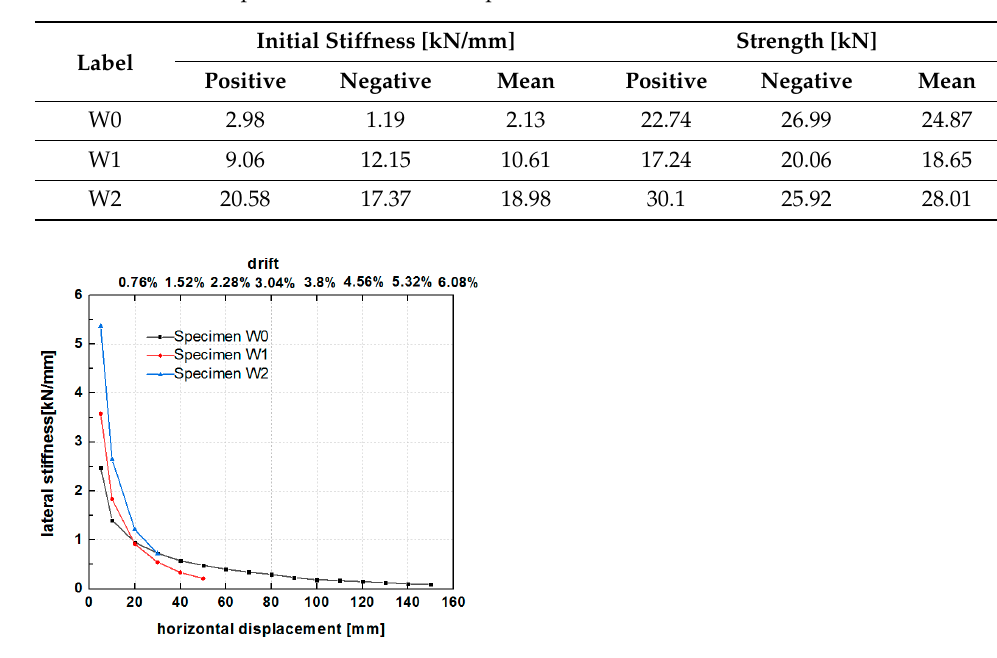
Figure 23. Stiffness degradation of specimens W0, W1, and W2.